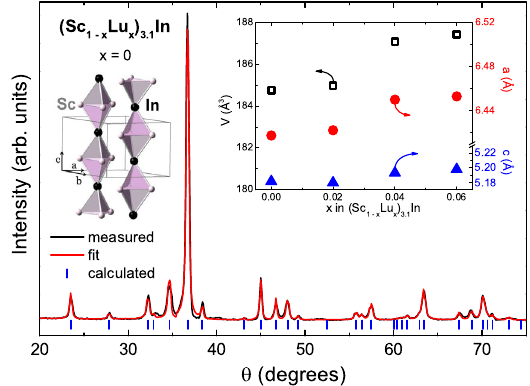
Þ Lu 3 . 1 In x x